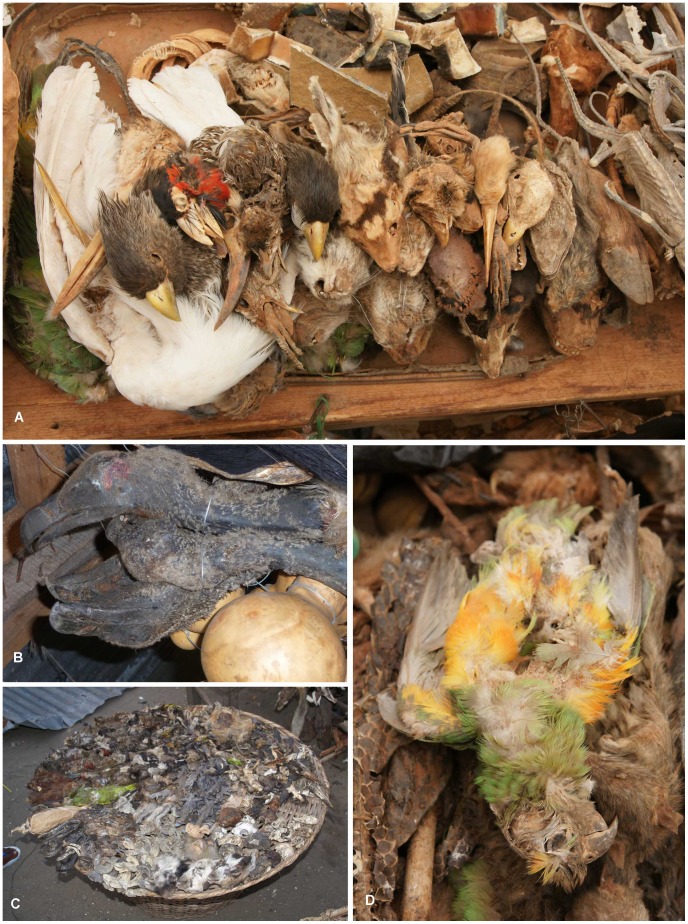
African bird species in the traditional medicine trade.
A. Heads of a variety of species, including a Western Grey Plantain-eater (Crinifer piscator), Double-toothed Barbet (Lybius bidentatus), Red-billed Hornbill (Tockus erythrorhynchus) and Double-spurred Francolin (Francolinus albogularis) (Ouagadougou market, Burkina Faso). B. Vultures and raptors, a high conservation priority group, sold here in Xipamanine market, Maputo, Mozambique. C. A basket of more than 15 species, including Broad-billed Roller (Eurystomis glaucurus), Fine-spotted Woodpecker (Campethera punctuligera), African Wood-Owl (Strix woodfordii), Rose-ringed Parakeet (Psittacula krameri), White Helmet-Shrike (Prionops plumatus), and Standard-winged Nightjar (Macrodipteryx longipennis) (Dantokpa market, Benin). D. Senegal Parrot (Poicephalus senegalus) (Ouagadougou market, Burkina Faso). [Photos: A.B. Cunningham]